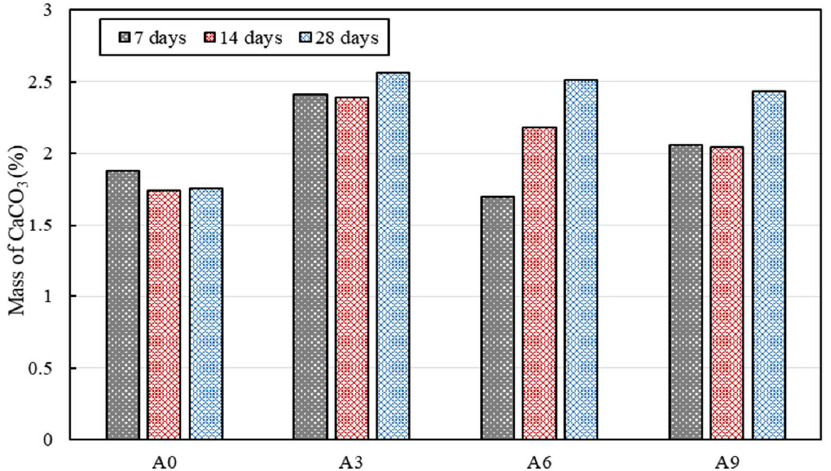
Figure 7. Mass of CaCO 3 in the paste specimens on 7th, 14th, and 28th days, quantified from TG results.